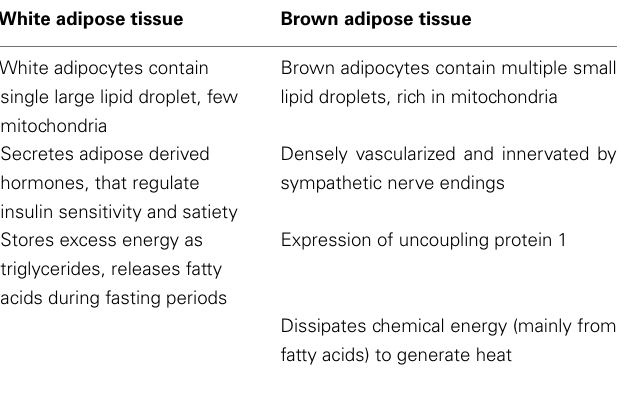
Table 1 | Characteristic of white vs. brown adipose